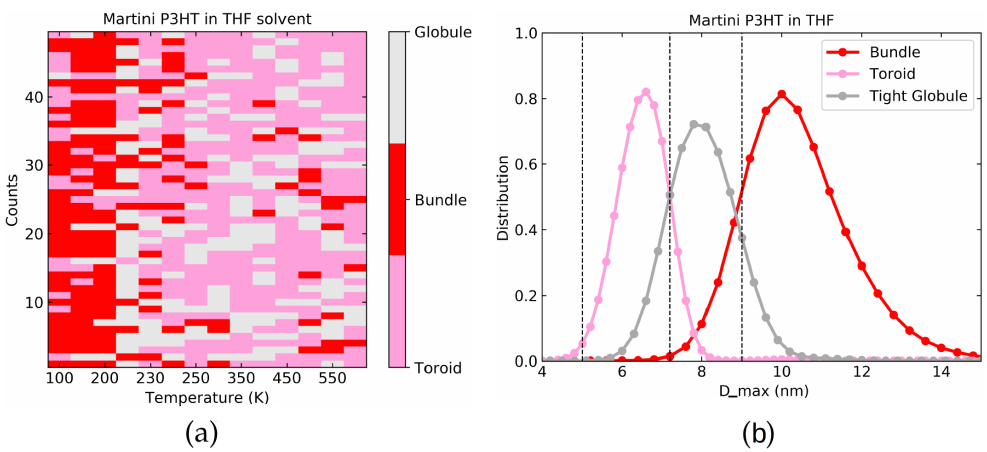
Figure 10. ( a ) Color coded final conformations at a range of temperature for 50 simulations for the Martini model of P3HT in THF solvent. ( b ) D max distributions used for toroid, globules and